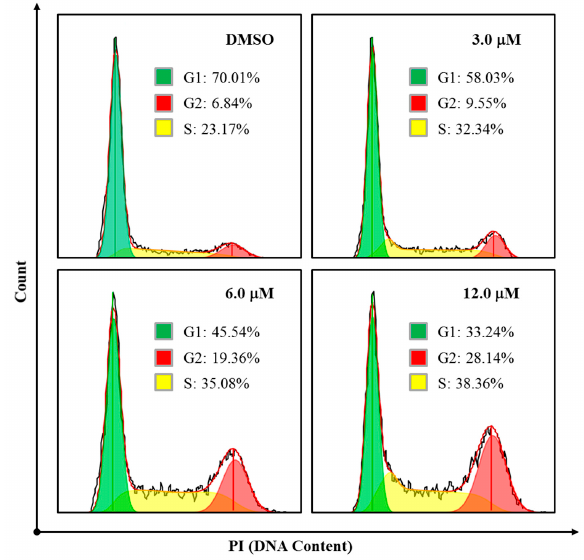
Figure 8. Compound 2 caused cell cycle arrest in the HeLa cells. The HeLa cells were treated with the vehicle control (DMSO) and Compound 2 for 36 h, at di ff erent concentrations, stained with PI, and then finally analyzed by flow